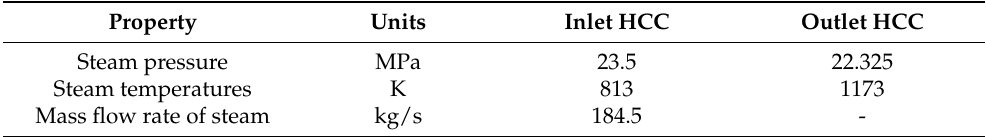
Table 2. Power unit net efficiency with the turbine coolant steam taken from the boiler headers at the initial temperature of 993 K. Property